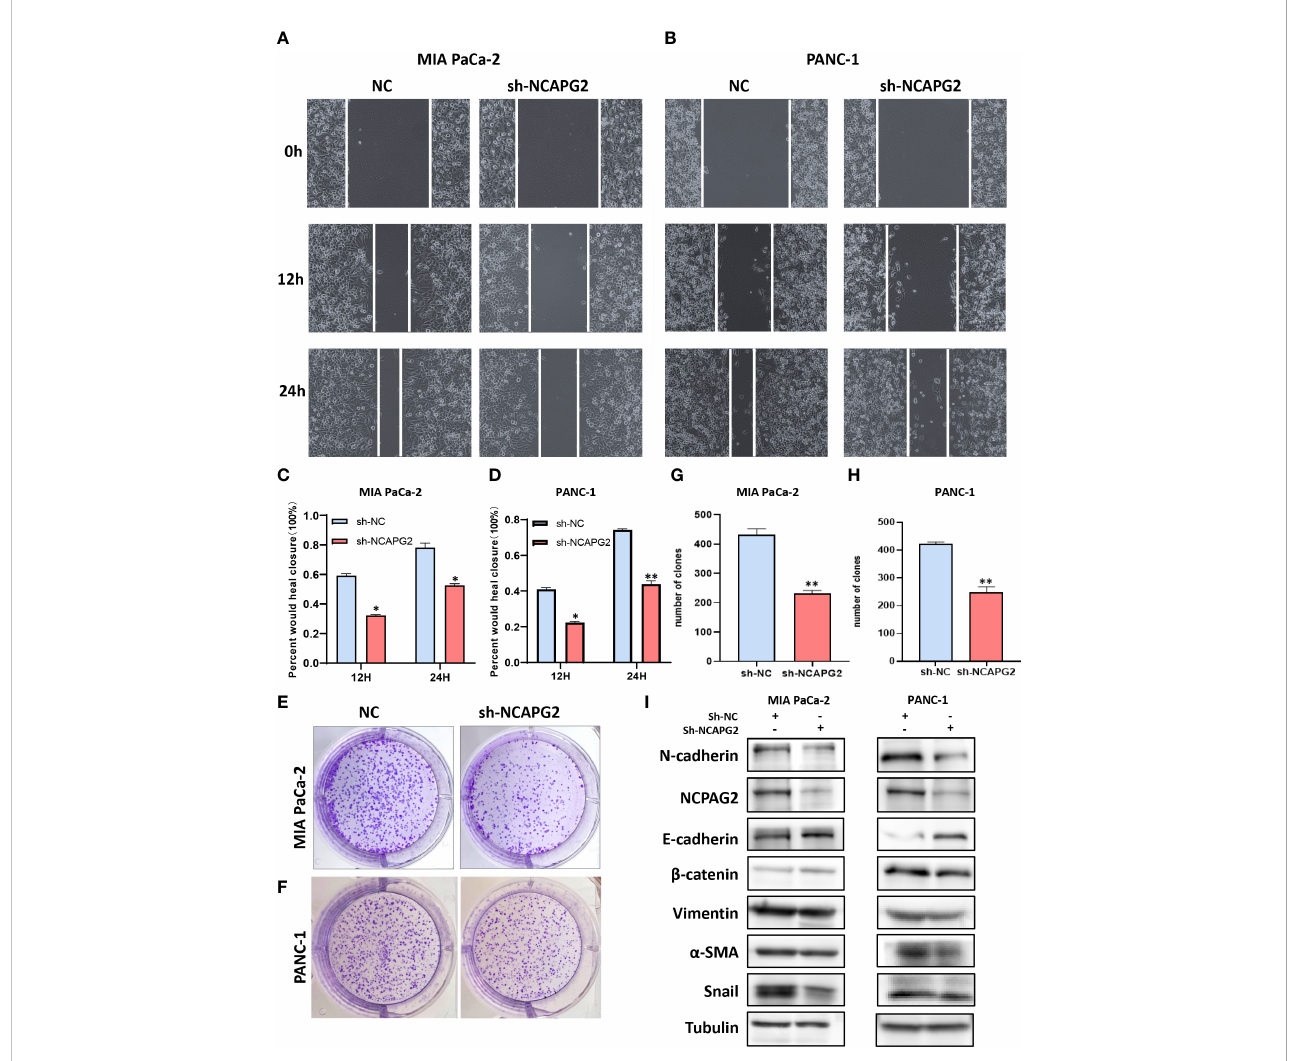
FIGURE 10 Functional effects of NCAPG2 on PC cells and their mechanisms. (A, B) Cell scratch assay detects migration ability; (C,D) Histogram shows the relative area of wound healing. (E, F) Colony formation assay was performed to compare the effect of NCAPG2 on proliferation. (G, H) Histograms shows the number of colony formation. (I) Western blotting detected the effect of sh-NCAPG2 on EMT markers. *p< 0.05;